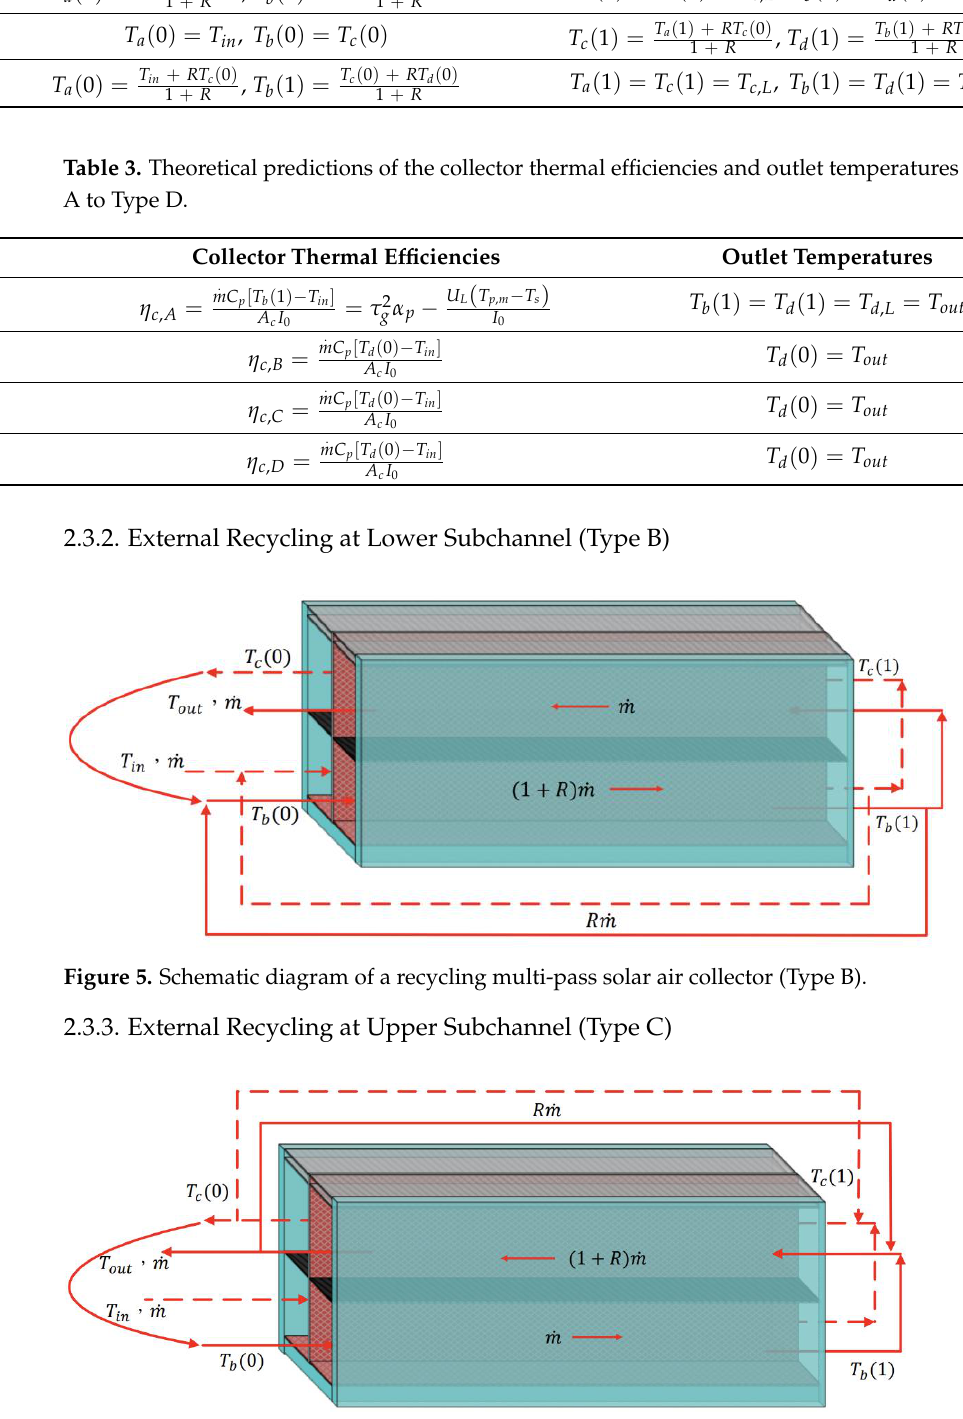
Figure 6. Schematic diagram of a recycling multi-pass solar air collector (Type C).